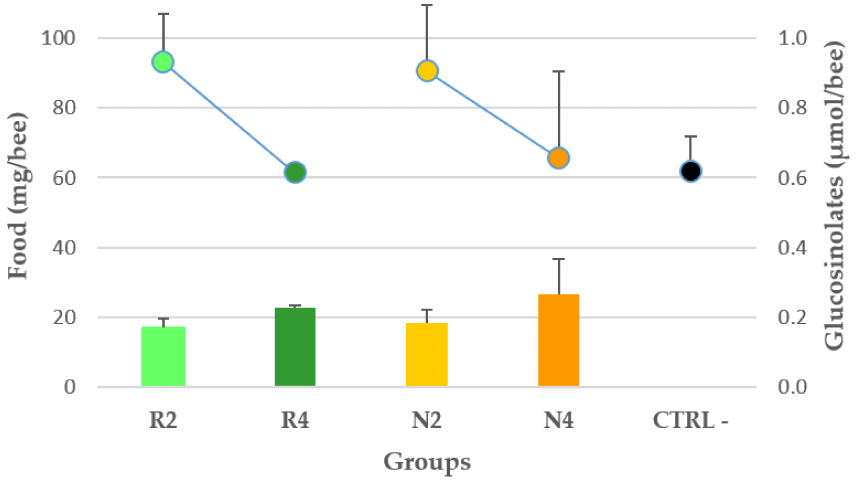
Figure 2. Cumulative individual food daily consumption of N. ceranae -infected treated groups (R2, R4, N2, N4) and CTRL − , expressed as mg/bee (dots—left y -axis), and relative cumulative individual GSL intake, expressed as ¦ µ mol/bees (columns–right y -axis), at 8 days post-infection. Vertical bars indicate the standard